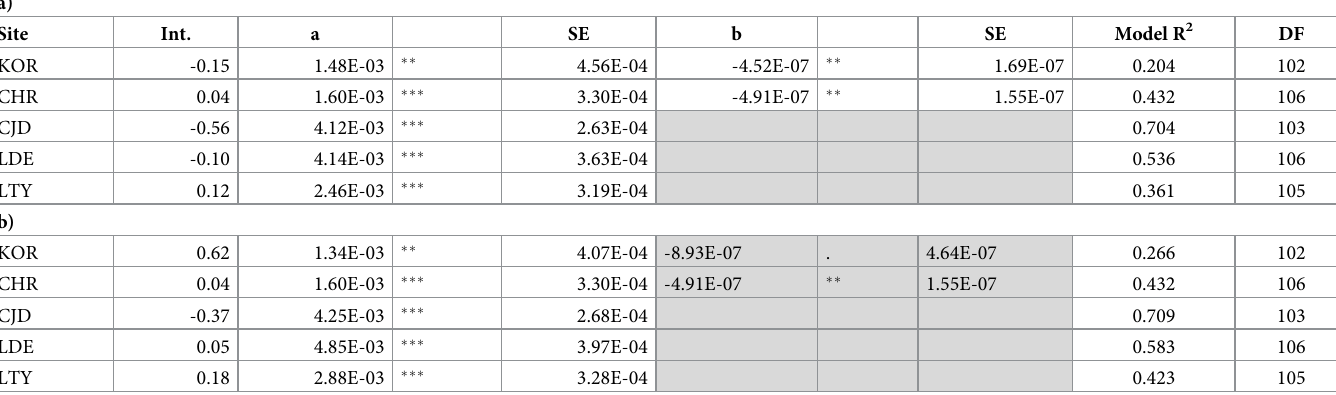
Table 3. Parameter estimates for regression models predicting ring-width index (RWI) from a) annual rainfall amount and b) “growing season” rainfall